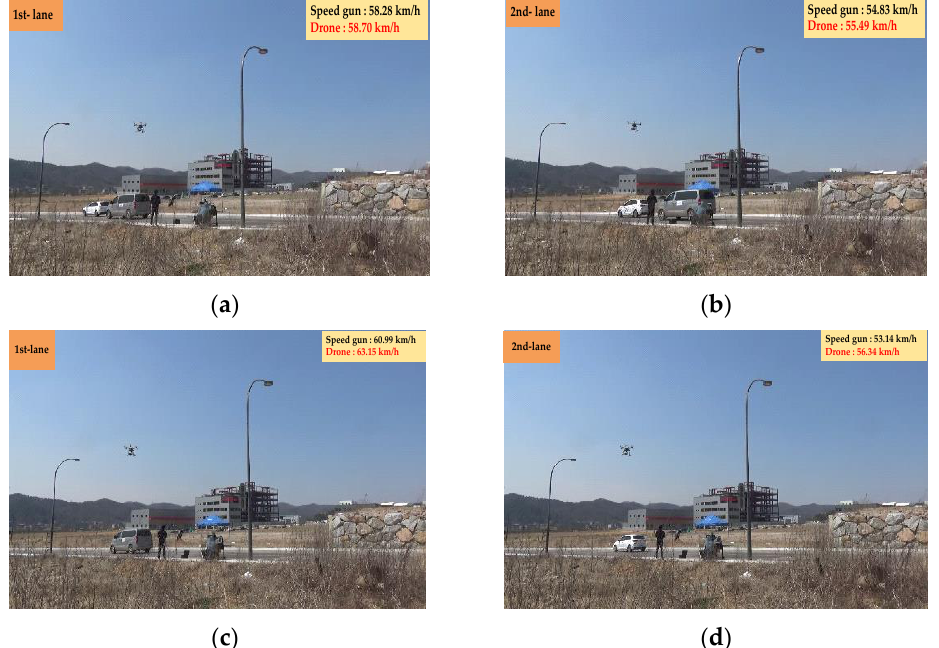
Figure 11. Vehicle speed experiment method on the first and second lanes; ( a ) speed gun 58.28 km/h and drone 58.70 km/h on the first lane; ( b ) speed gun 54.83 km/h and drone 55.49 km/h on the second lane; ( c ) speed gun 60.99 km/h and drone 63.15 km/h on the first lane; ( d ) speed gun 53.14 km/h and drone 56.34 km/h on the second lane. Table 1 shows the velocity of the vehicle driving in the first and the second lanes using the drone and the speed gun. The speed gun’s average error and the drone in the first and the second lanes are 0.58 km/h and 1.06 km/h, respectively. The speed gun and the drone’s root mean square error (RMSE) represent 0.75 km/h and 1.31 km/h in the first and second lanes, respectively. The average error probability between the speed gun and the drone is 1.2% and 2.05% in the first and second lanes, respectively. Table 1. Comparison of the vehicle measurements for the speed gun and the drone on the multi-lane. Measurement Velocity on First Lane Measurement Velocity on Second lane